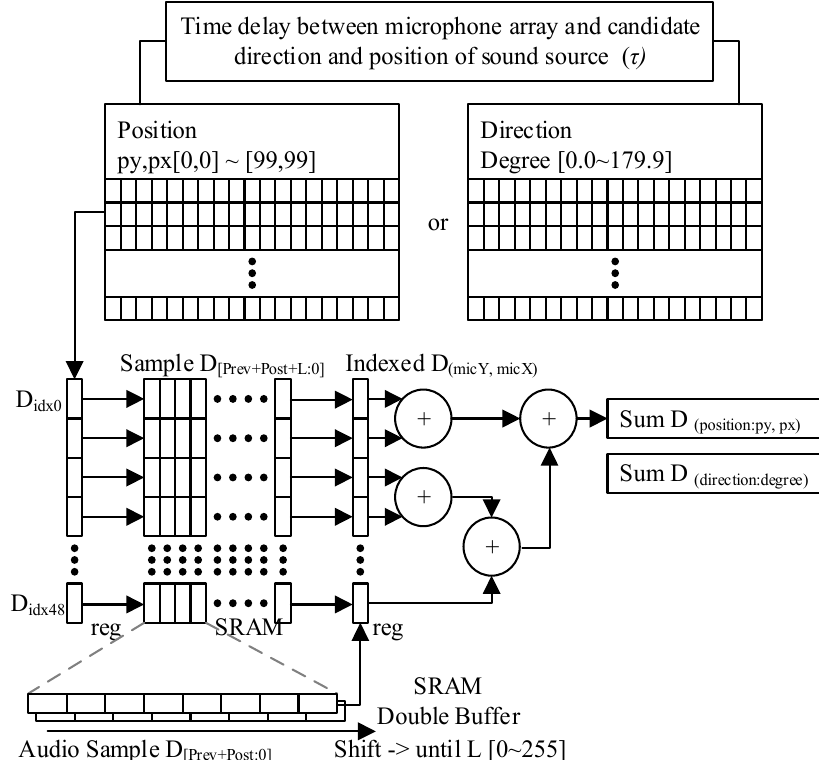
Figure 6. FPGA-based design of the DSBF processor.